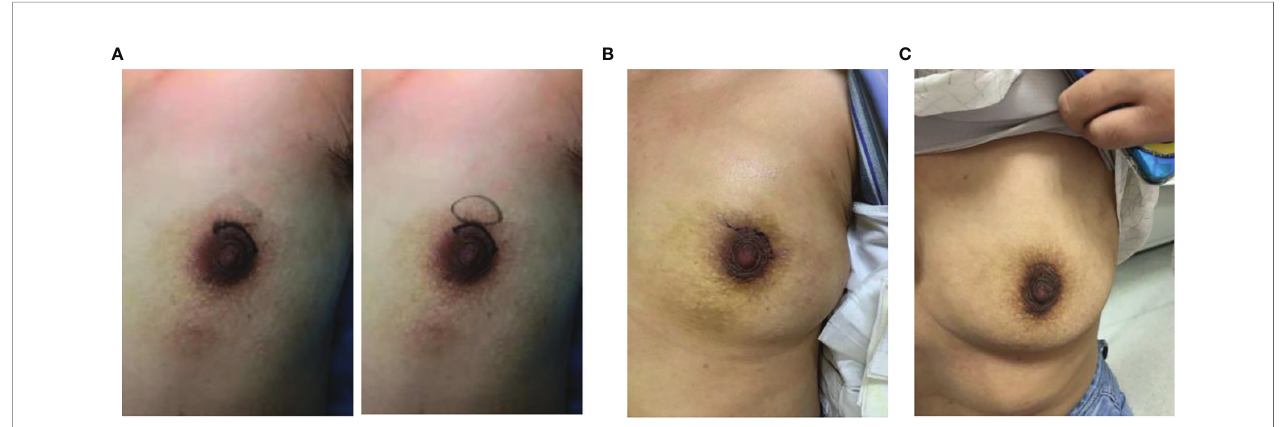
FIGURE 3 | Typical representative photos of GLM before surgery (A) , one week after surgery (B) , and one month after surgery (C) .